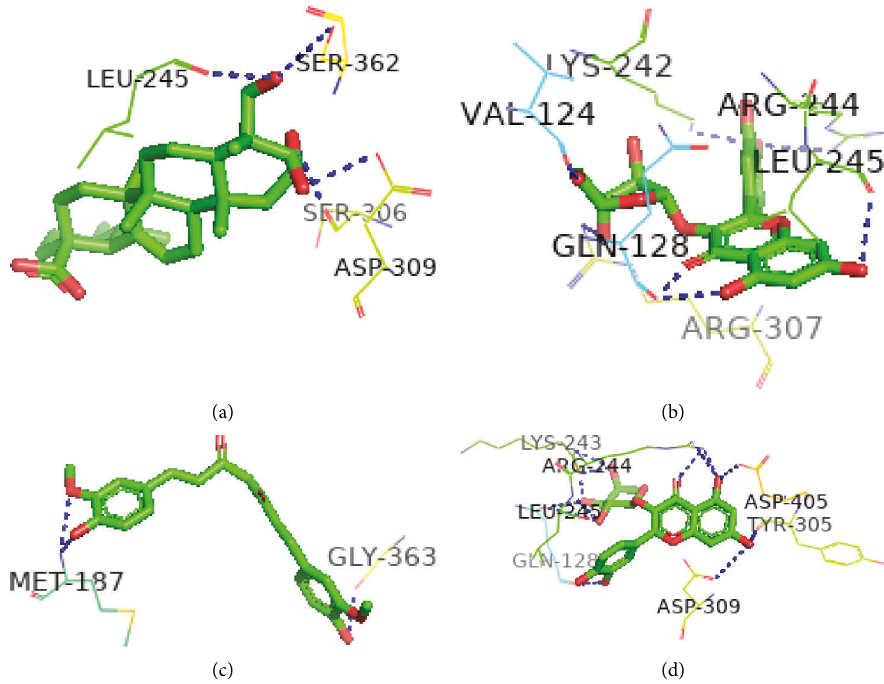
Figure 8: Polar binding sites of P22 with (a) Asiatic acid, (b) avicularin, (c) curcumin, (d) guaijaverin.